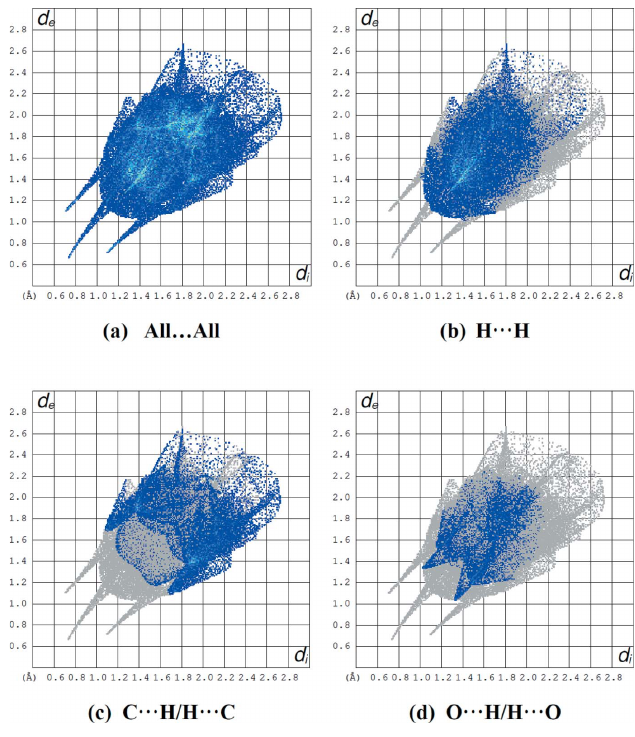
Figure 5 A view of the two-dimensional fingerprint plots for the title compound, showing ( a ) all interactions, and delineated into ( b ) H (cid:2)(cid:2)(cid:2) H, ( c ) C (cid:2)(cid:2)(cid:2) H/ H (cid:2)(cid:2)(cid:2) C and ( d ) O (cid:2)(cid:2)(cid:2) H/H (cid:2)(cid:2)(cid:2) O interactions. The d i and d e values are the closest internal and external distances (in A˚ ) from given points on the Hirshfeld